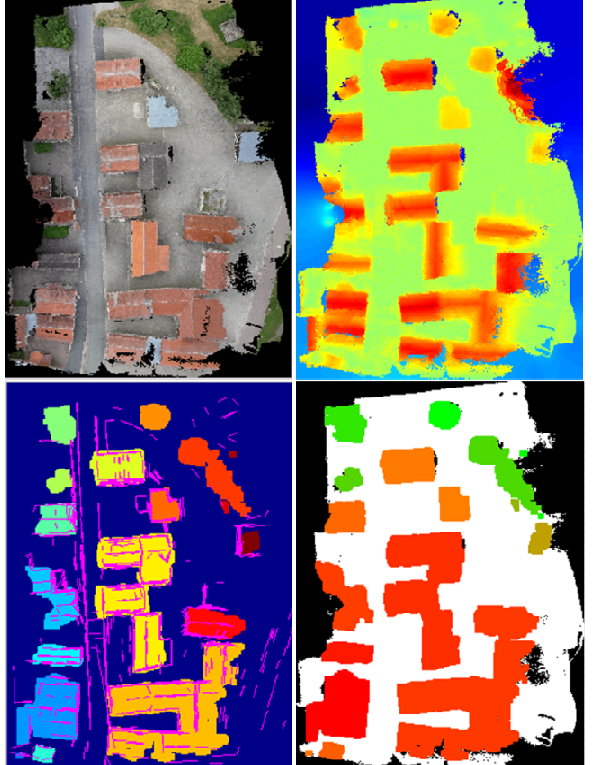
Figure 4: Top left: the synthetic image J illustrating the rasteri- zation of the RGB-values from video frames into the xy -domain; top right the corresponding difference of DSM (fused rasterized depth maps) and DTM. Bottom left: regions found in B together with line segments depicted in magenta; bottom right: Lineness measure of the regions; those corresponding to areas of vege- tation are marked in green and those to buildings in red.